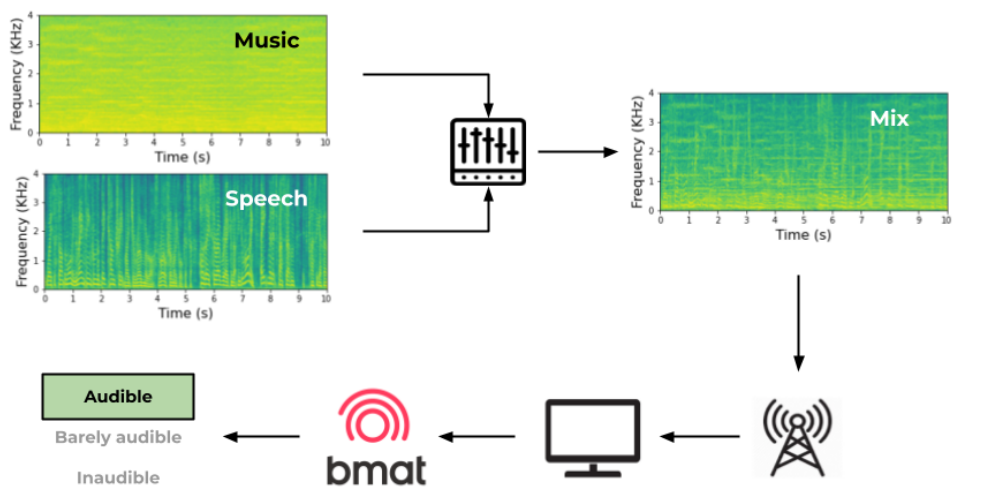
Figure 1. Representation of case